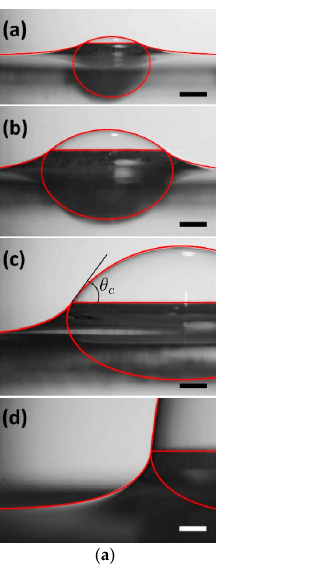
Figure 8. Comparison of the presently computed bubble profiles (red outlines) with the experimental photographs obtained by ( a ) Reprinted with permission from [37]. Copyright 2015 American Chemical Society (from top to bottom X c = (a) 1, (b) 2.1, (c) 4.2 and (d) 32.5 mm) and ( b ) Reprinted from [36], with the permission of AIP Publishing. Table 2. The angle of the junction point ( θ c ) as measured experimentally by Teixeira et al. [37] and as predicted in the present work.